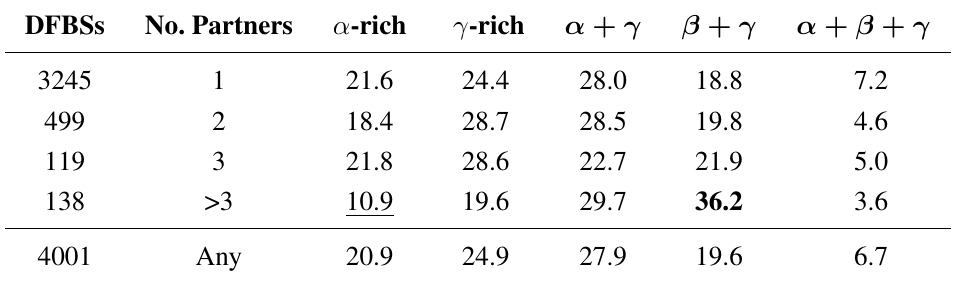
Table 5. Distribution of DFBSs in the five SSE classes (percent units) depending on the number of Pfam partners. Significant differences from the global distribution (last row) are indicated with underlined or bold characters for lower or higher percentages, respectively.